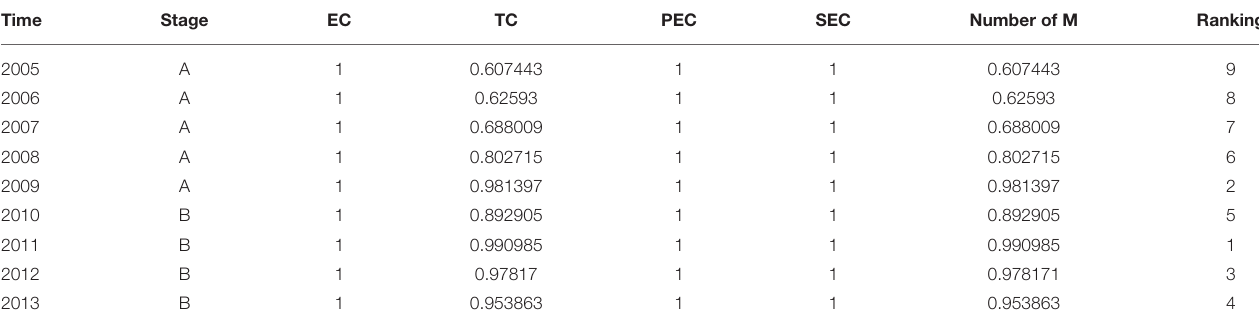
TABLE 4 | Results of the DEA–Malmquist method. Time Stage EC TC PEC SEC Number of